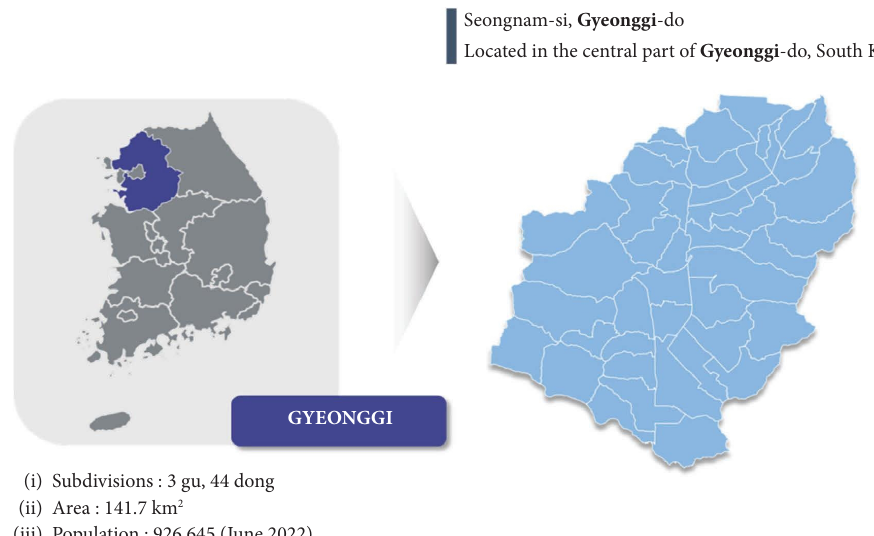
Figure 2: Seongnam